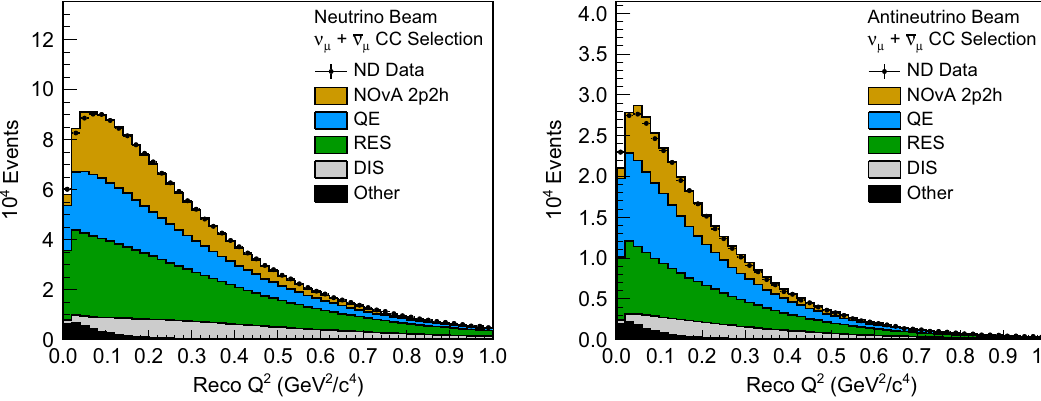
Fig. 15 Comparison of fully adjusted simulation to data in reconstructed Q 2 , for neutrino beam (left) and antineutrino beam